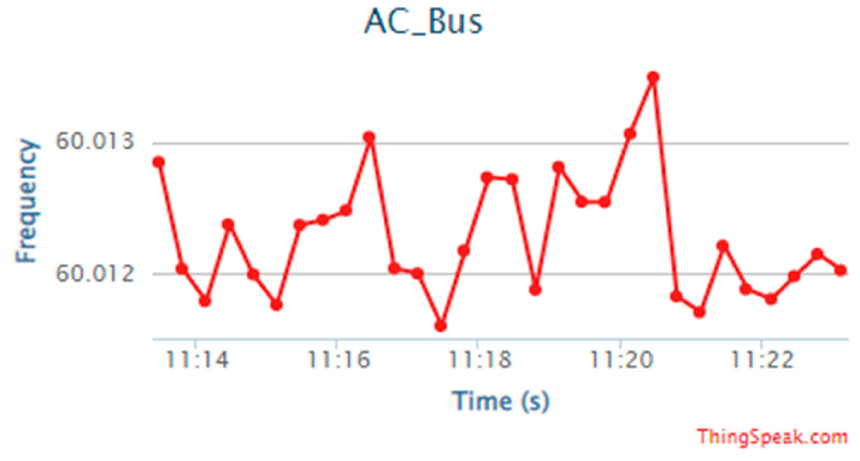
Figure 21. The frequency at the AC bus.